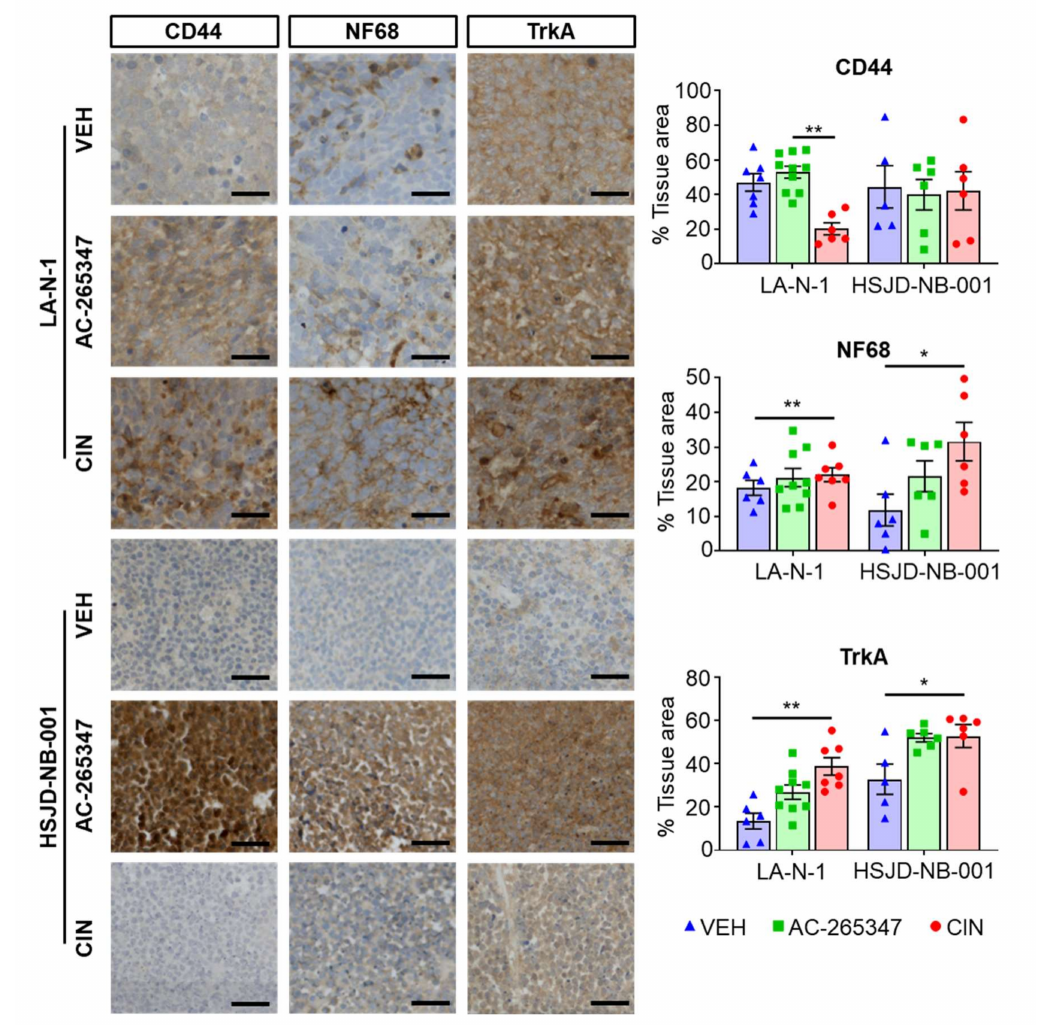
Figure 2. Expression of NB differentiation markers is increased by exposure to calcimimetics. ( Left ) Immunohistochemistry performed with anti-CD44, anti-NF68 and anti-TrkA antibodies in sections of LA-N-1 and HSJD-NB-001 tumors exposed to calcimimetics or vehicle. ( Right ) Whole tumor scan was acquired with TissueFAXS at × 20 magnification and percentage of positive area per tumor was quantified using STRATA Quest. Each symbol represents an individual tumor and lines represent mean ± SD. Significance was calculated using One-way ANOVE using a Dunn’s correction test. * p < 0.05, ** p < 0.01. Scale represents 100 µ